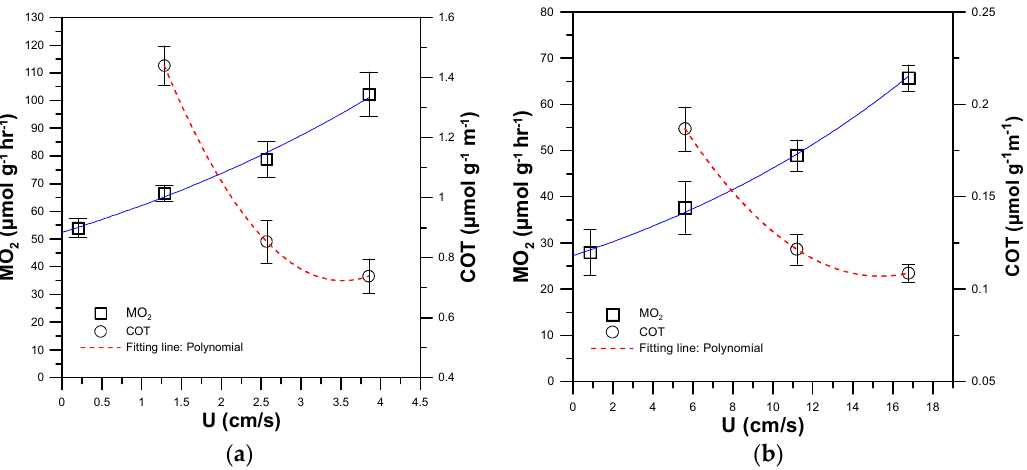
Figure 6. Representative results of the aqueous oxygen concentration (DO) over time for a single 30 dpf larval zebrafish swimming at the water flow of ( a ) 1.28 cm/s, and ( b ) 3.85 cm/s, using automated intermittent-flow respirometry. intermittent-flow respirometry.